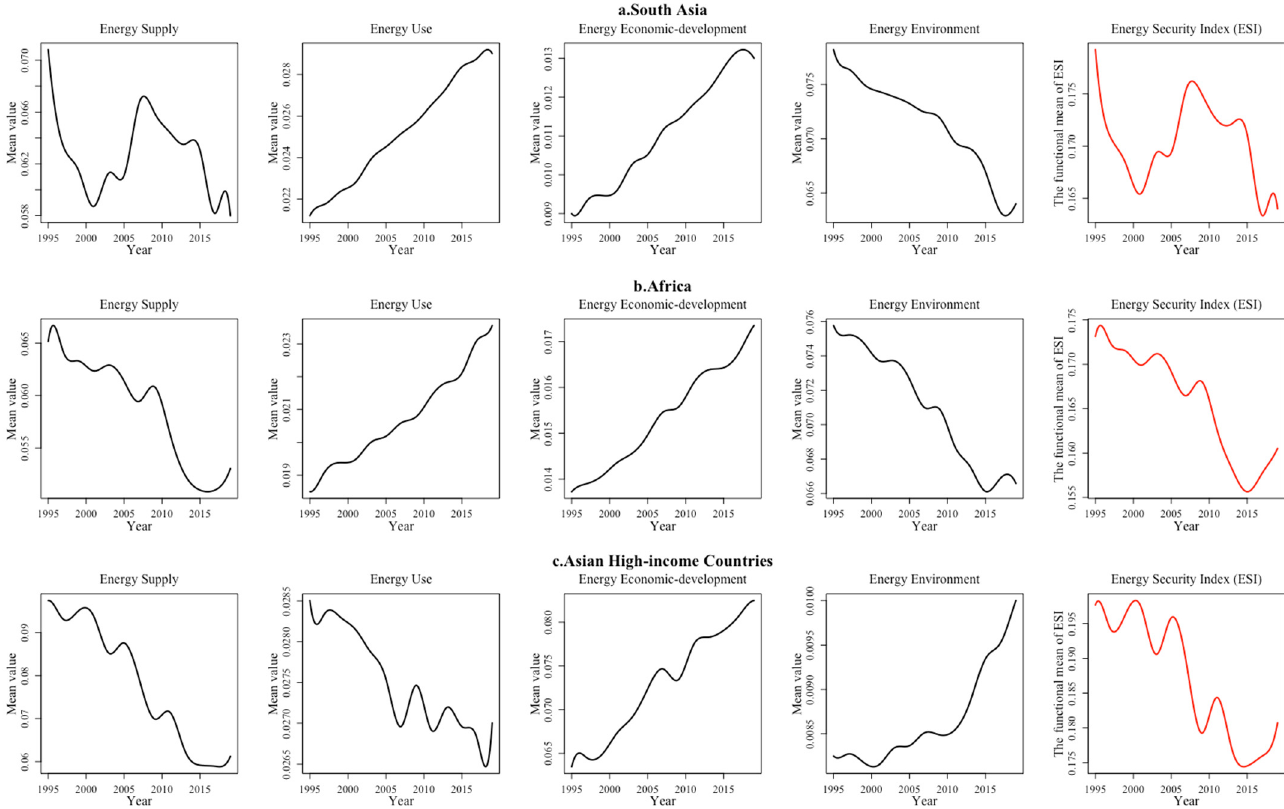
Figure 12. “Poor” and “Worse” regional energy security system performance in five dimensions.